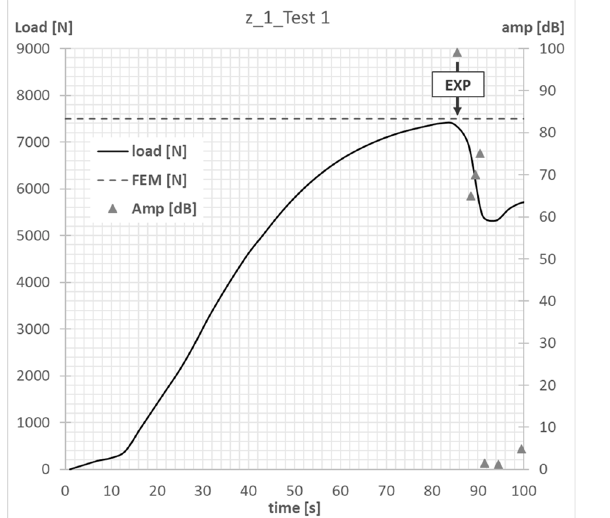
( b ) Figure 8. Column z_2—failure initiation force: ( a ) axial compression—Test 1; ( b ) eccentricity—Test 3.